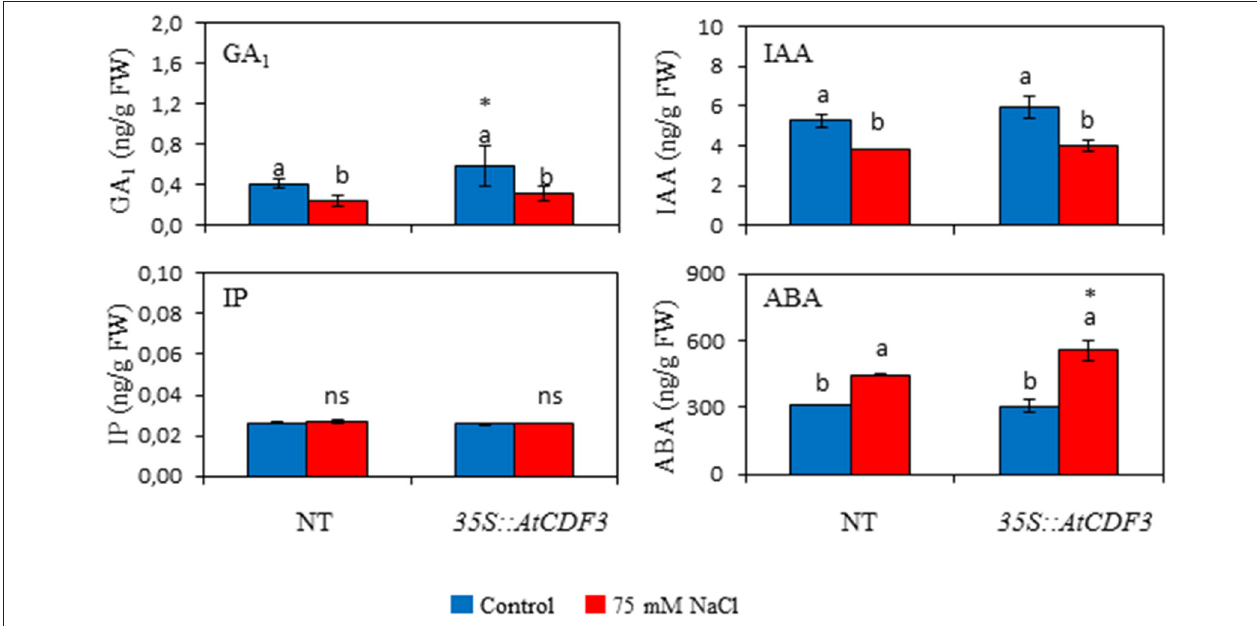
FIGURE 8 | Effect of AtCDF3 overexpression on leaf hormone content in tomato. Thirty-day-old NT and 35S::AtCDF3 (L 2.3) plants grown in hydroponic culture were subjected to control and moderate salinity (75 mM NaCl) conditions. Hormone determinations were performed after 15 days of treatment. The GA 1 , IAA, IP, and ABA levels in leaves were shown under the control (blue bars) and salinity (red bars) conditions. Different letters indicate the significant differences ( P < 0.05) within each genotype for the stress effect. Differences between genotypes per treatment are indicated by an asterisk. NT,